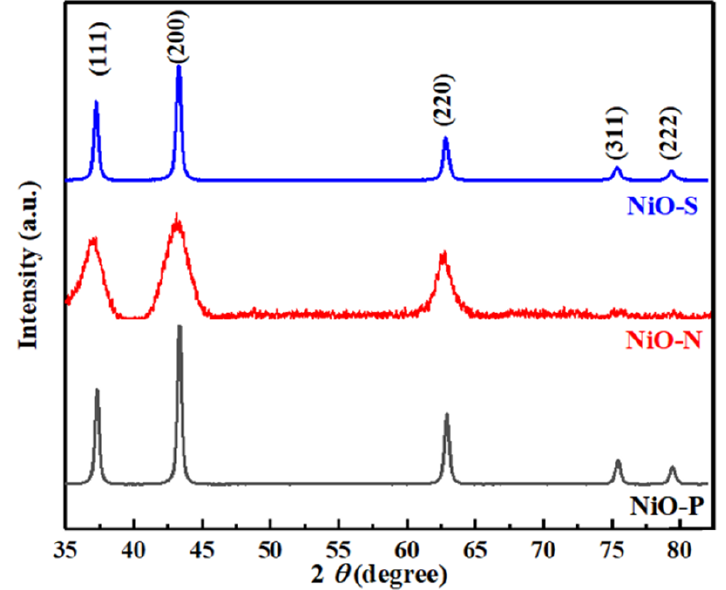
Figure 2. The XRD pattern of NiO-P, NiO-N, and NiO-S. A scanning electron microscope (SEM)(JEOL Ltd., Tokyo, Japan) was utilized to study the surface micromorphology of the NiO hollow spheres. Figure 3 shows the SEM of NiO-P, NiO-N, and NiO-S. It could be seen that all of the obtained NiO spheres were hollow. Among them, the size of NiO-P was relatively non-uniform, and the diameter of the spheres was 1–4 µ m. At the same time, NiO-P was composed of many small particles, leading to a porous structure on its surface. This porous structure facilitated the diffusion of gases. The size of NiO-N was uniform, and the diameter of the spheres was ~1 µ m. The surface was smoother than NiO-P and NiO-S. The diameter of the NiO-S spheres was about 2 µ m, and the overall shape of the spheres was inapparent. Its outer shell was made up of densely packed nanosheets, which enlarged the adsorption sites of gas molecules. Moreover, it is beneficial to gas-sensing reactions. The different surface morphologies of NiO-P, NiO-N, and NiO-S might greatly affect the sensitive performance of the gas